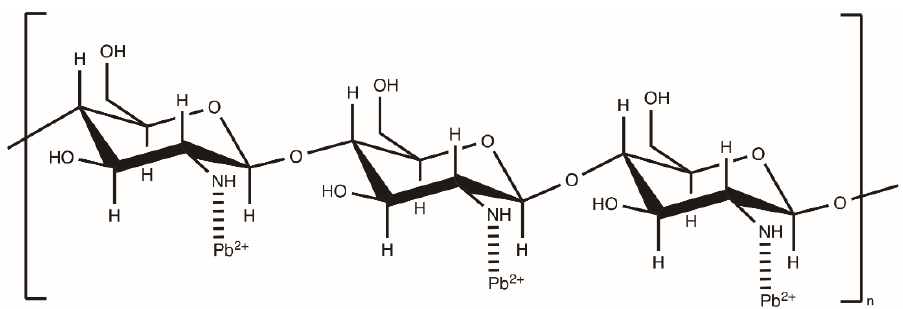
Figure 6. Scheme of the possible interaction between chitosan and Pb(II) (prepared on [31]). The 18. composites had a better adsorbed amount of BSA in comparison with pure PUR [47]. The protein adsorption was improved with the increase of molecular weight of